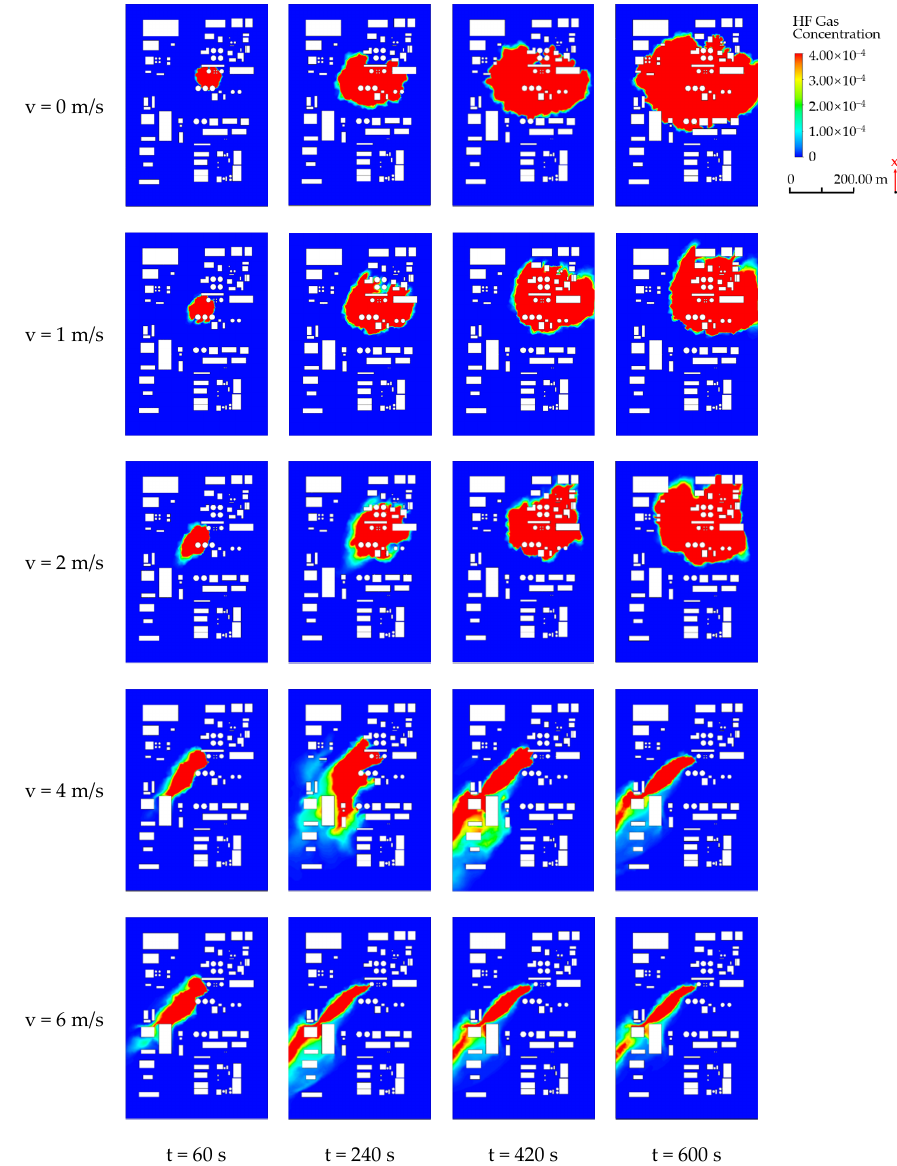
Figure 3. Changes in HF concentration distribution with time at 1.8 m height under different wind speeds (The red area is the lethal area).